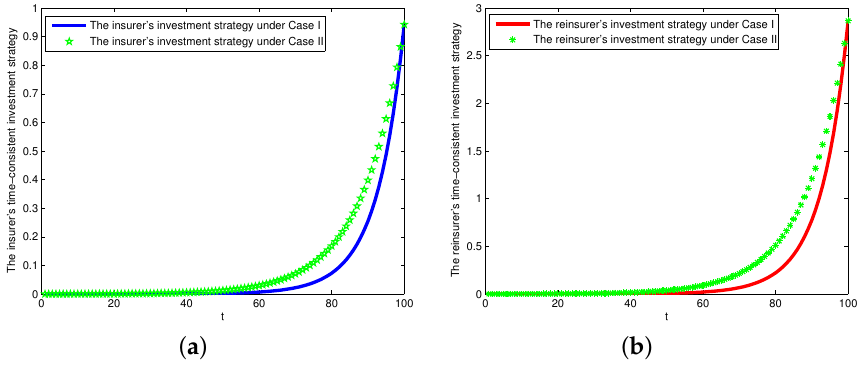
Figure 1. Nash equilibrium investment strategies for ( a ) the insurer and ( b ) the reinsurer ( α = 0.2 and x =